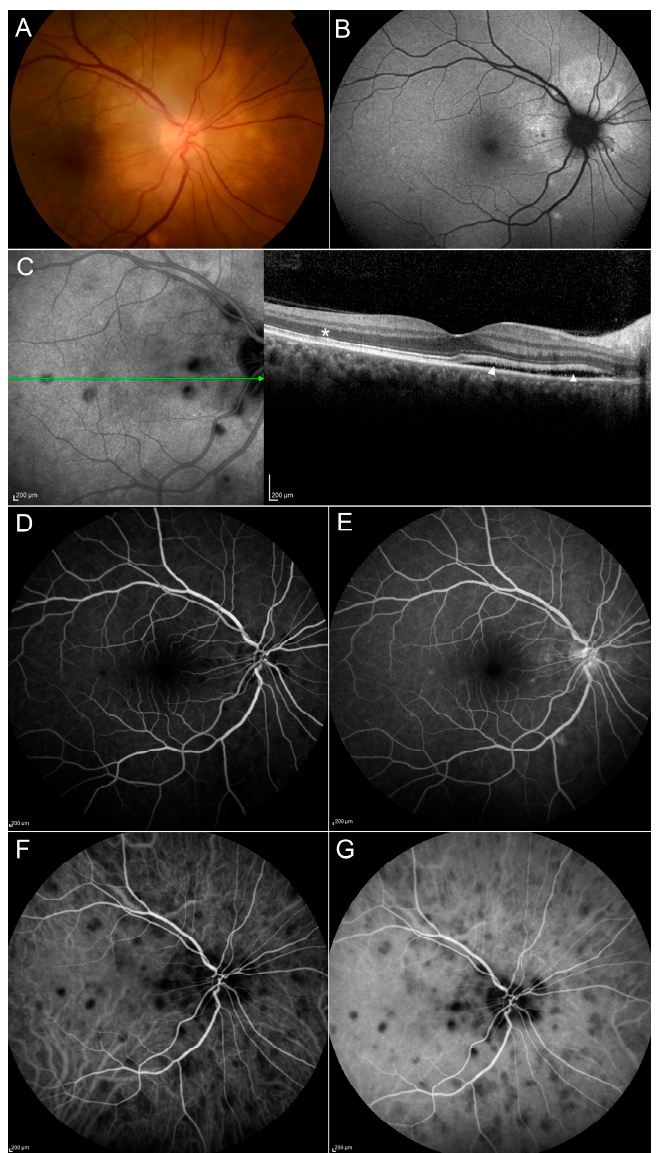
Figure 5. Case 2, ocular tubercles. Fundus photo ( A ) evidences the presence of multiple, yellowish lesions with indistinct borders. Edema around the optic disc ( A ) is better evidenced with B-FAF (hyperfluorescent) and OCT scan ( C ), showing the area of retinal pigmented epithelium (RPE) detachment ( arrowheads ). Contact sign over the tubercle can be seen ( asterisk ) on OCT ( C ). Granulomas are characterized by early hypo-fluorescence ( D ) and late hyper-fluorescence ( E ) after fluorescein injection. ICGA examination shows the presence of regular-shaped, hypocyanescent lesions from the early ( F ) to the late stages ( G ) of the examination.